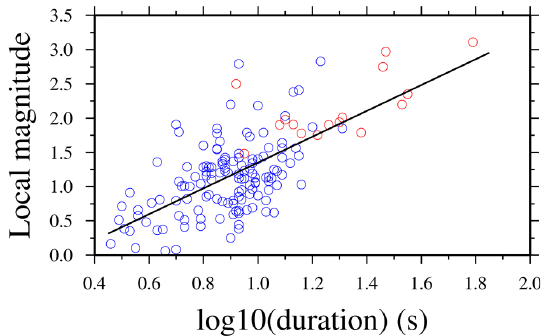
Fig. 5. Magnitude-coda duration distribution of 150 HF events with a given M L . The 134 events from the Konstantinou et al. (2007) dataset are plotted as blue circles and the 16 CWB events as red cir- cles (linear correlation co-efficient equal to 0.7). The least-squares linear regression result is shown with the black solid line (see text for more